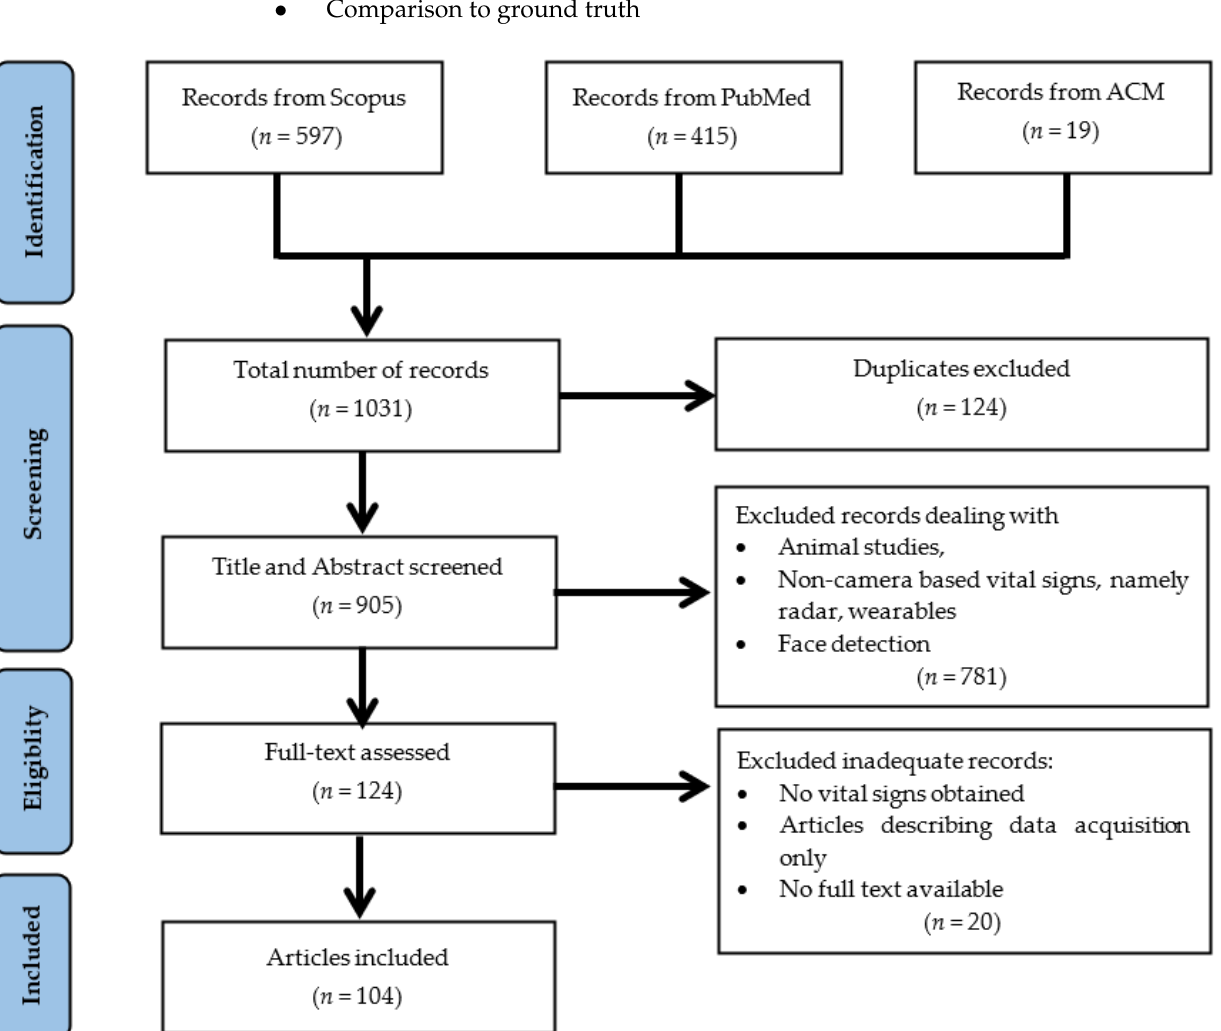
Figure 1. PRISMA diagram of literature screening.